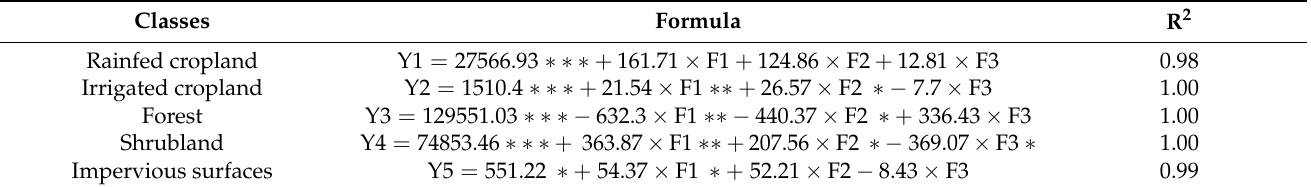
Table 4. Relationships between major LUC types areas and principal components in different